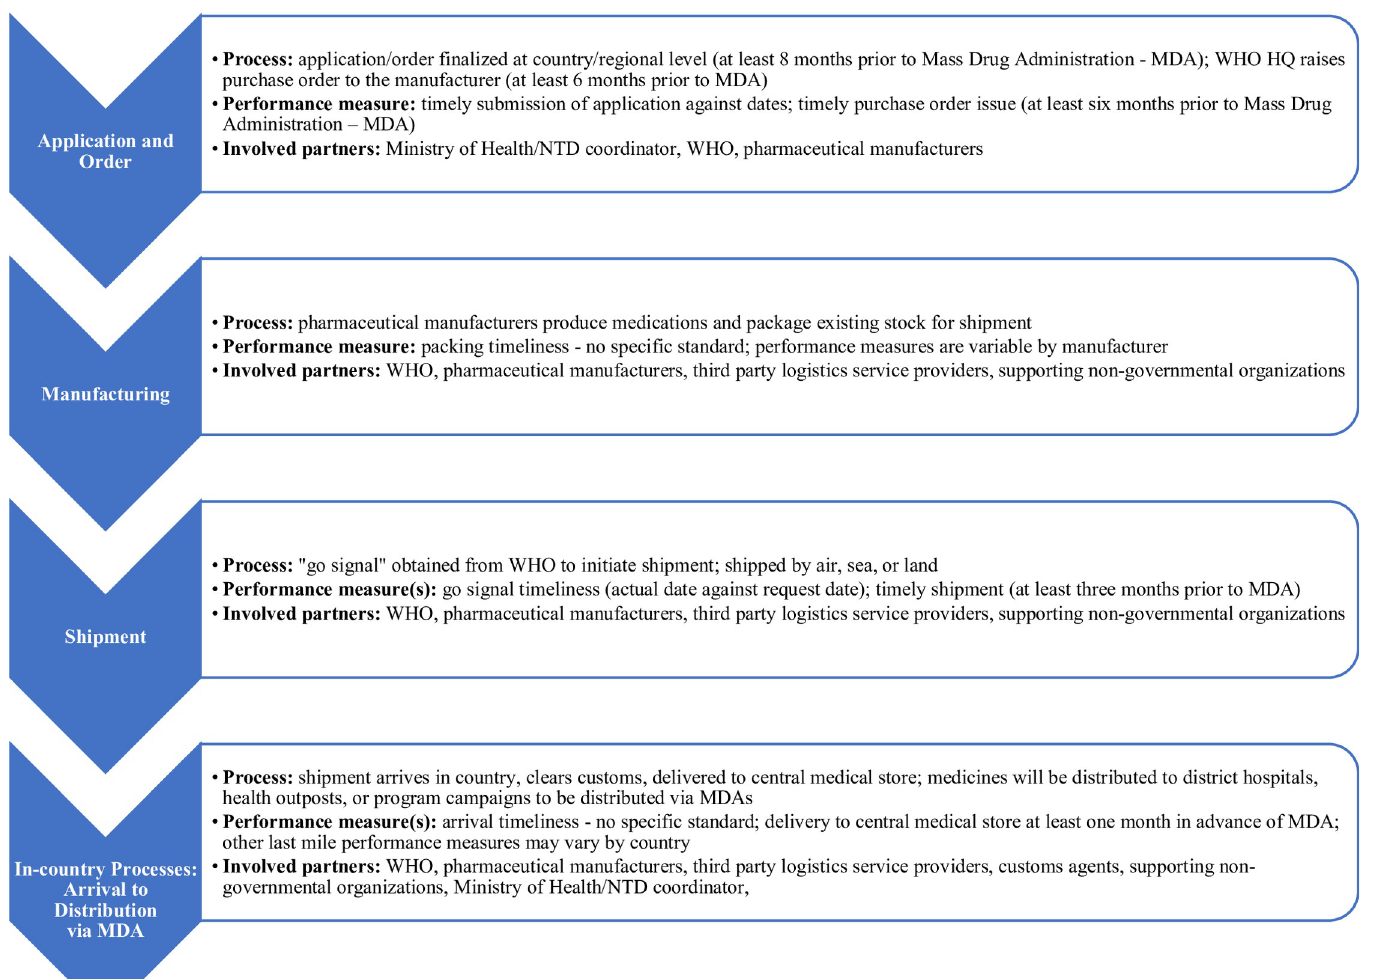
PLOS NeglectedTropical Diseases | https://doi.org/10.1371/journal.pntd.0009523 November29,